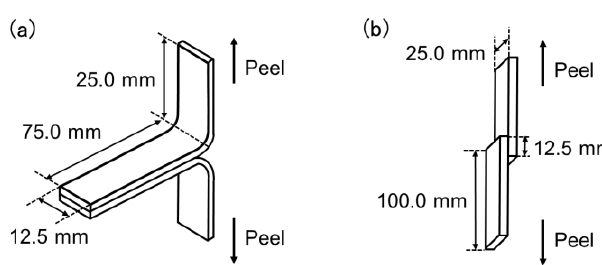
Figure 2. Schematics of the test specimen: ( a ) T-peel test; ( b ) tensile shear test.